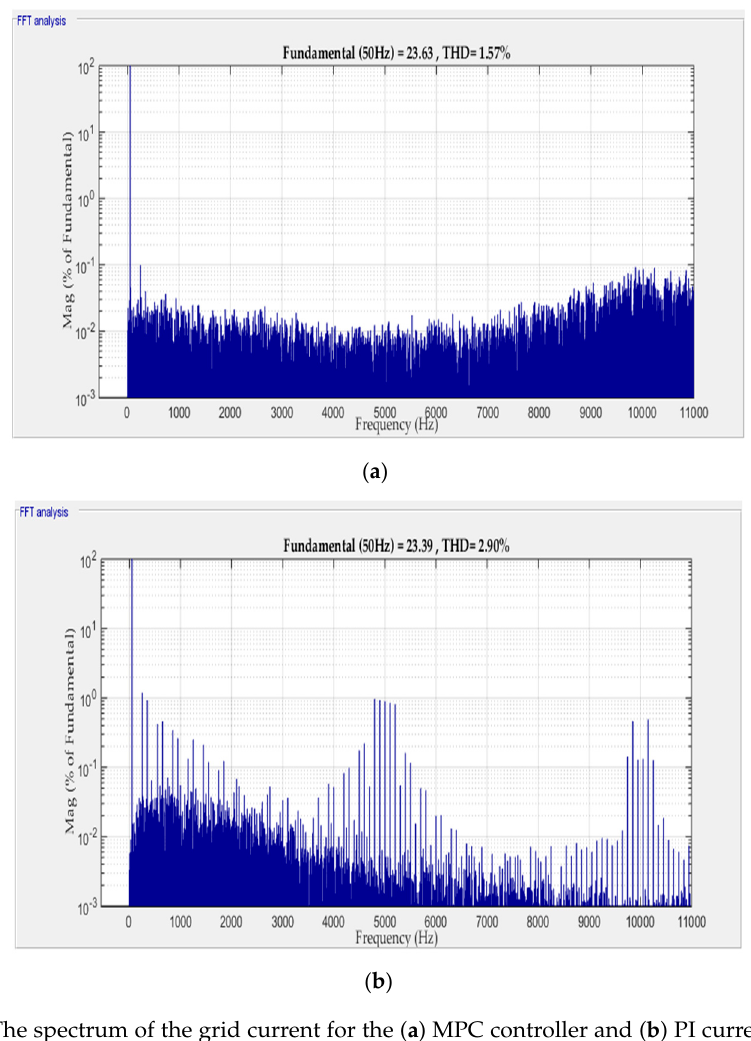
Figure 11. The spectrum of the grid current for the ( a ) MPC controller and ( b ) PI current controller with SPW modulation (@75%insolation).